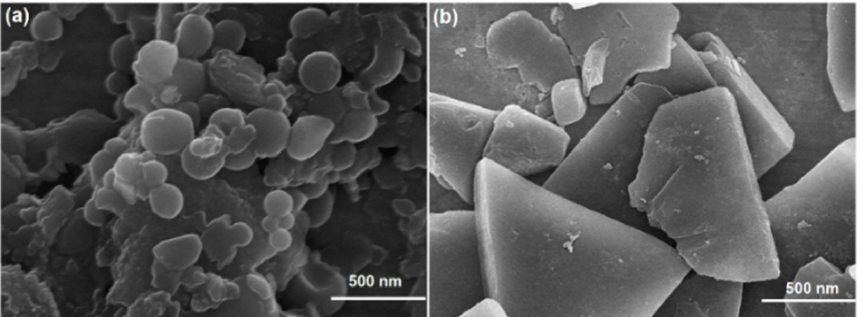
Figure 5. FE-SEM images for the morphology of compounds 1 ( a ) and 2 ( b ).